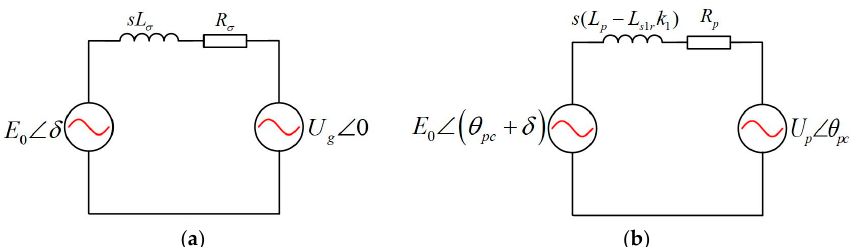
Figure 2. Comparison of the equivalent circuits of ( a ) Synchronous Generator (SG) and ( b ) Brushless Doubly Fed Induction Generator (BDFIG).